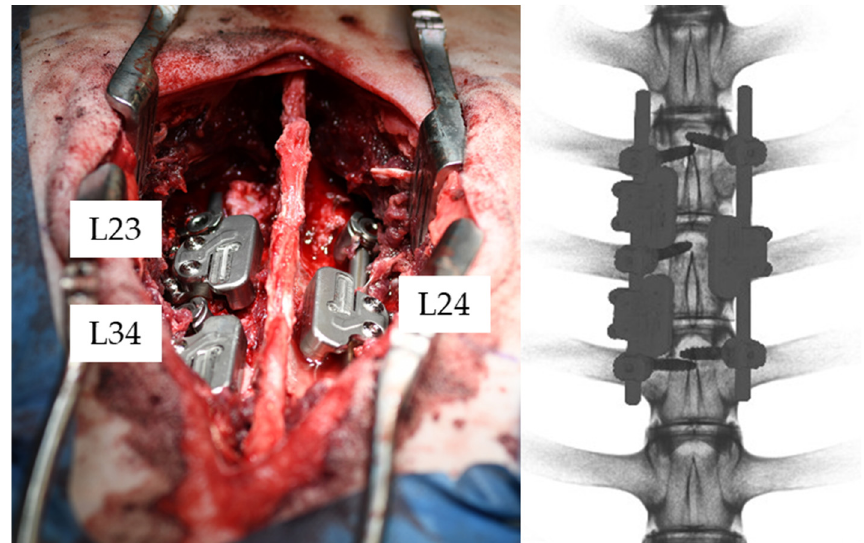
Figure 2. ( Left ) Intraoperative image after spinal instrumentation and placement of the sensors (L23, L34, L24). ( Right ) Posterior-anterior view from the postoperative CT scan (L1–L5). The sensors were checked intraoperatively to ensure functionality before